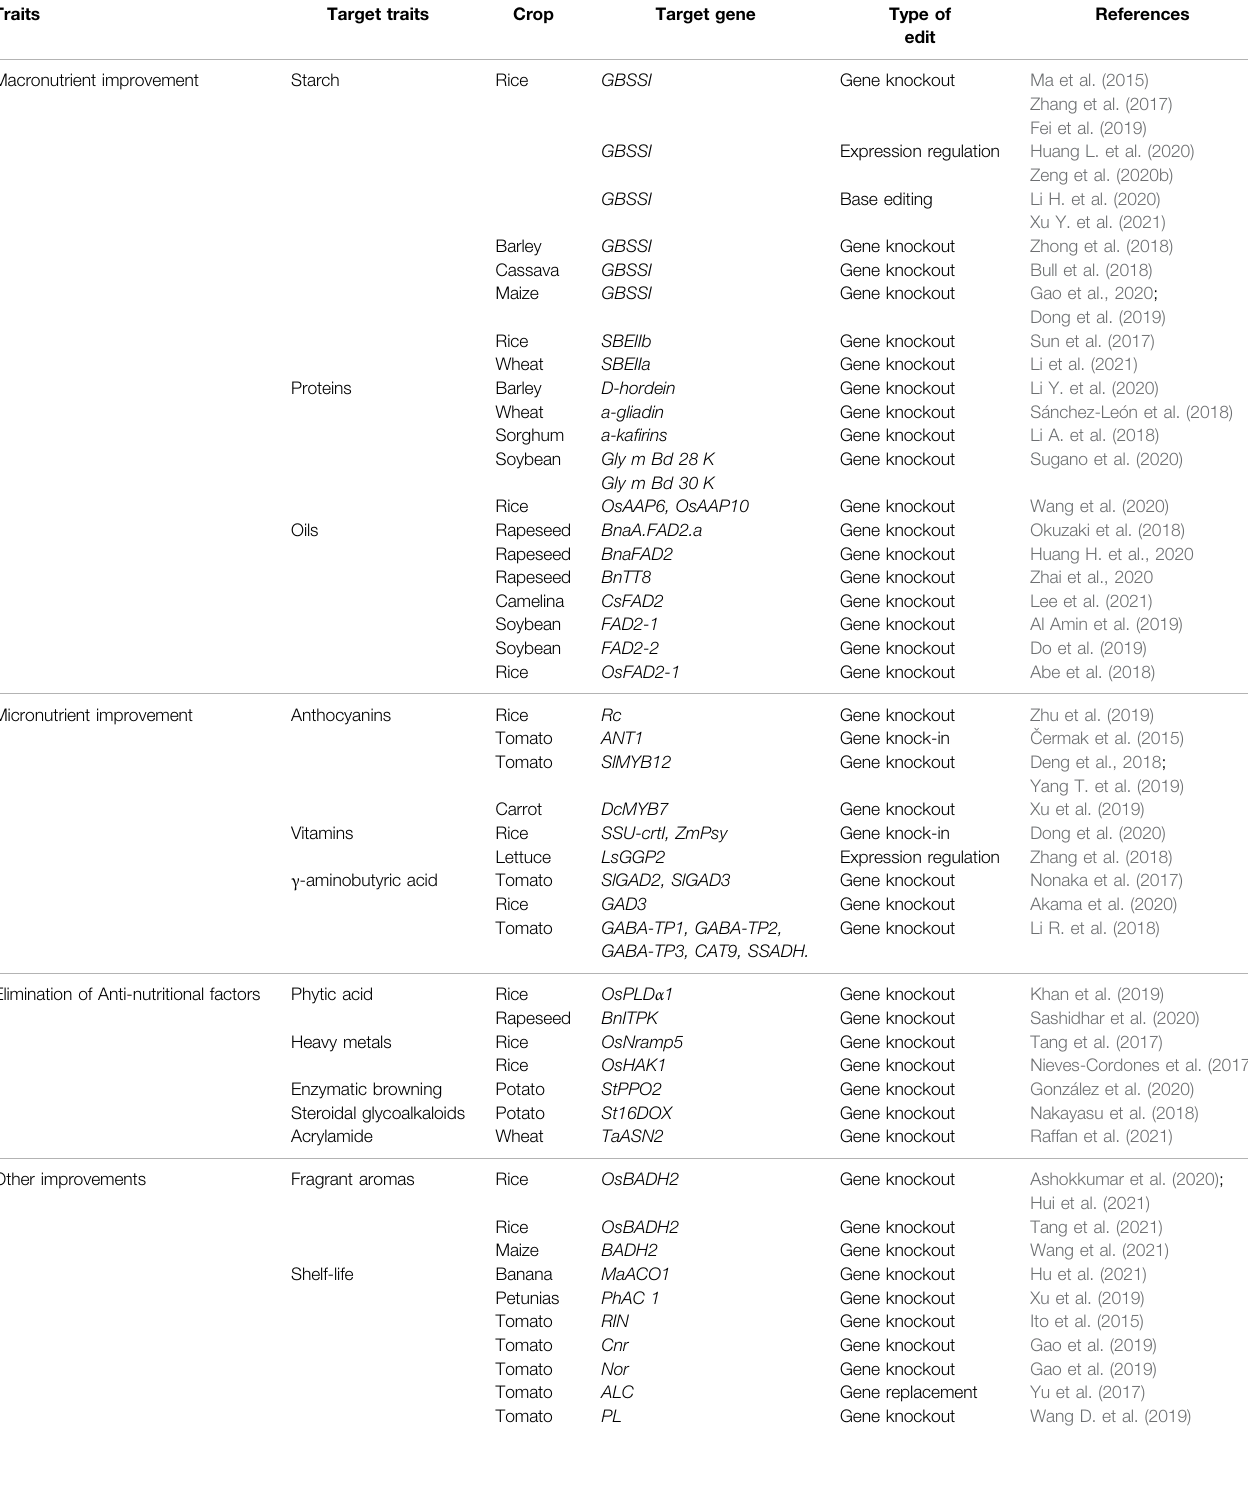
TABLE 1 | List of research on crop quality improvement by using CRISPR/Cas9